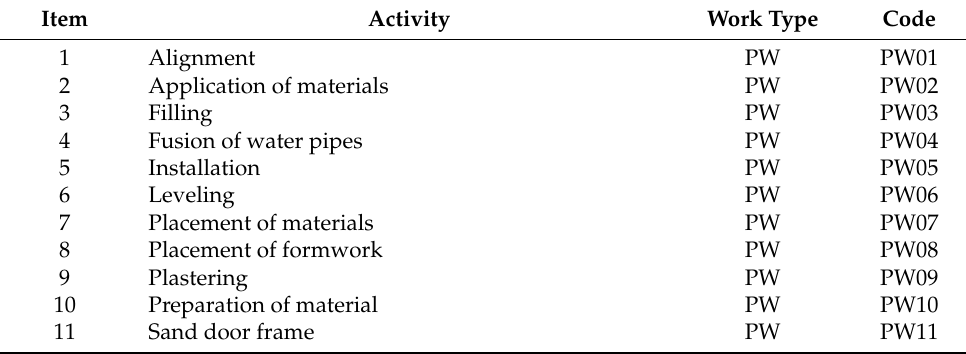
Table 3. Groups of activities result from the